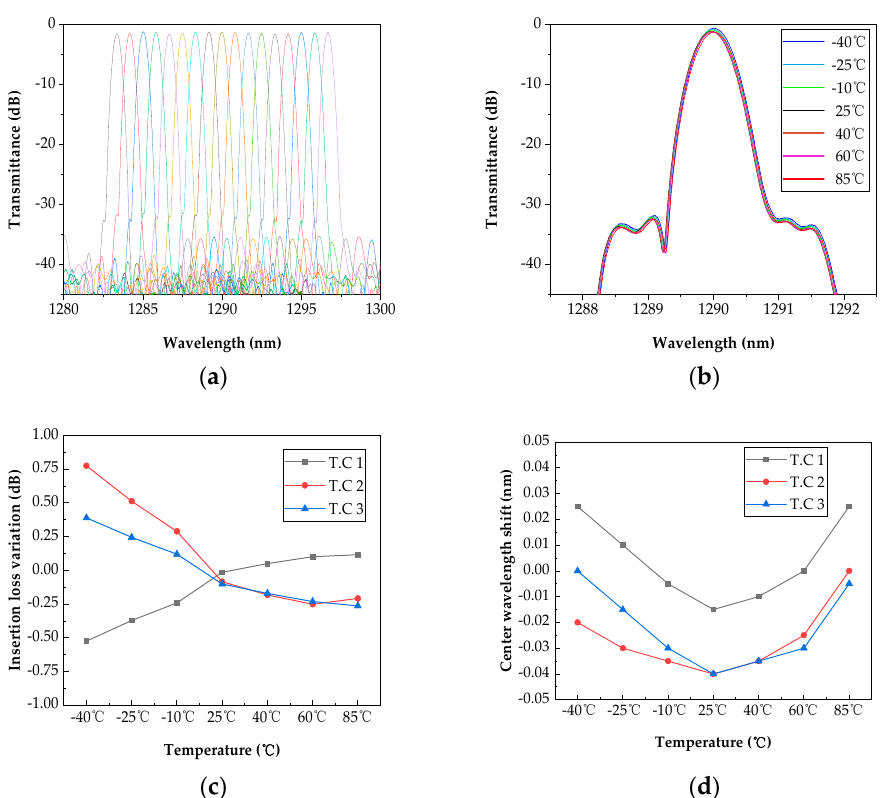
Figure 5. Temperature dependence of 17-channel AAWG module: ( a ) Spectrum of 17-channel AAWG module; ( b ) Temperature dependence of C.W.; ( c ) IL deviation of the temperature dependence for each of the three modules; ( d ) C.W. shift of the temperature dependence for each of the three